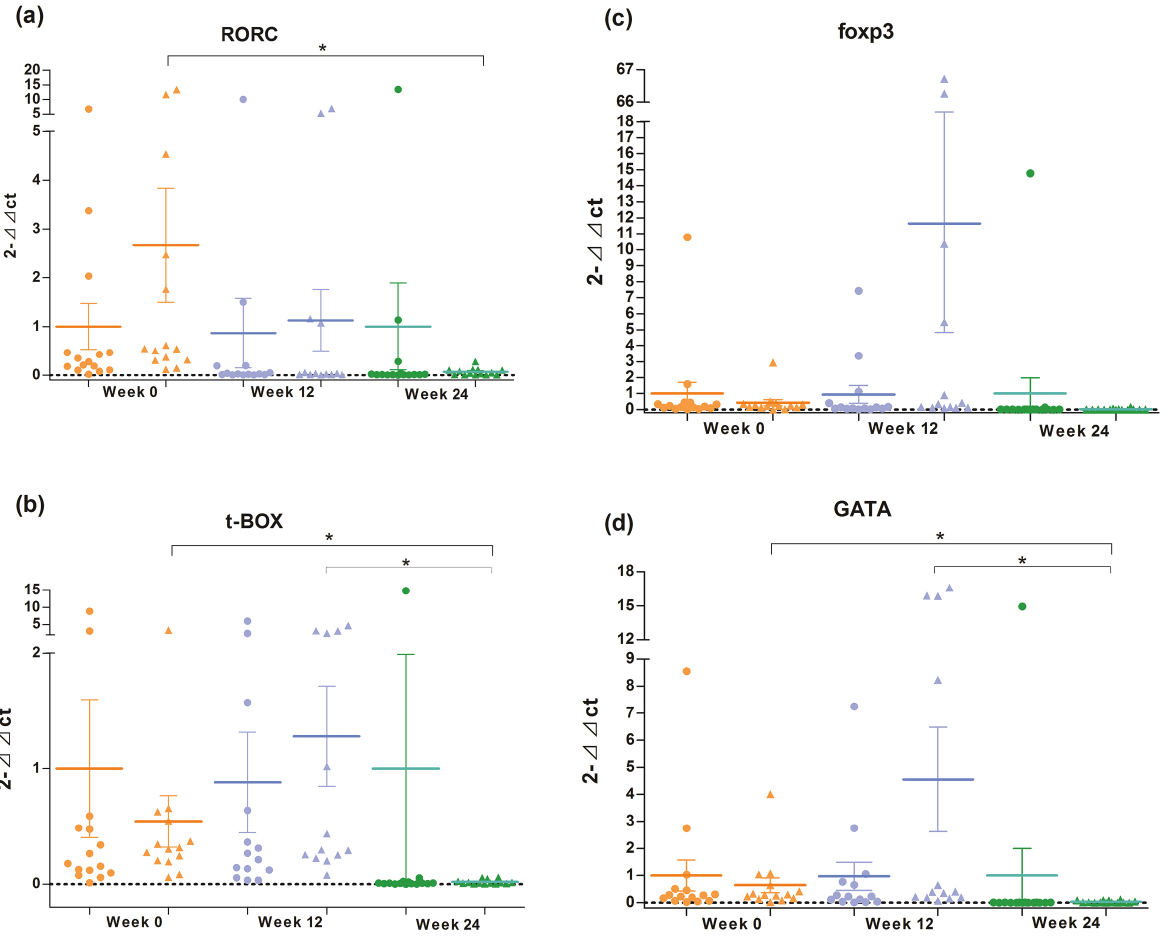
FIGURE 3 - Intergroup and intragroup comparisons of RORC (a) , t-BOX (b) , foxp3 (c) and GATA (d) mRNA levels at weeks 0, 12 and 24. ● stands for P group, and ▲ stands for U